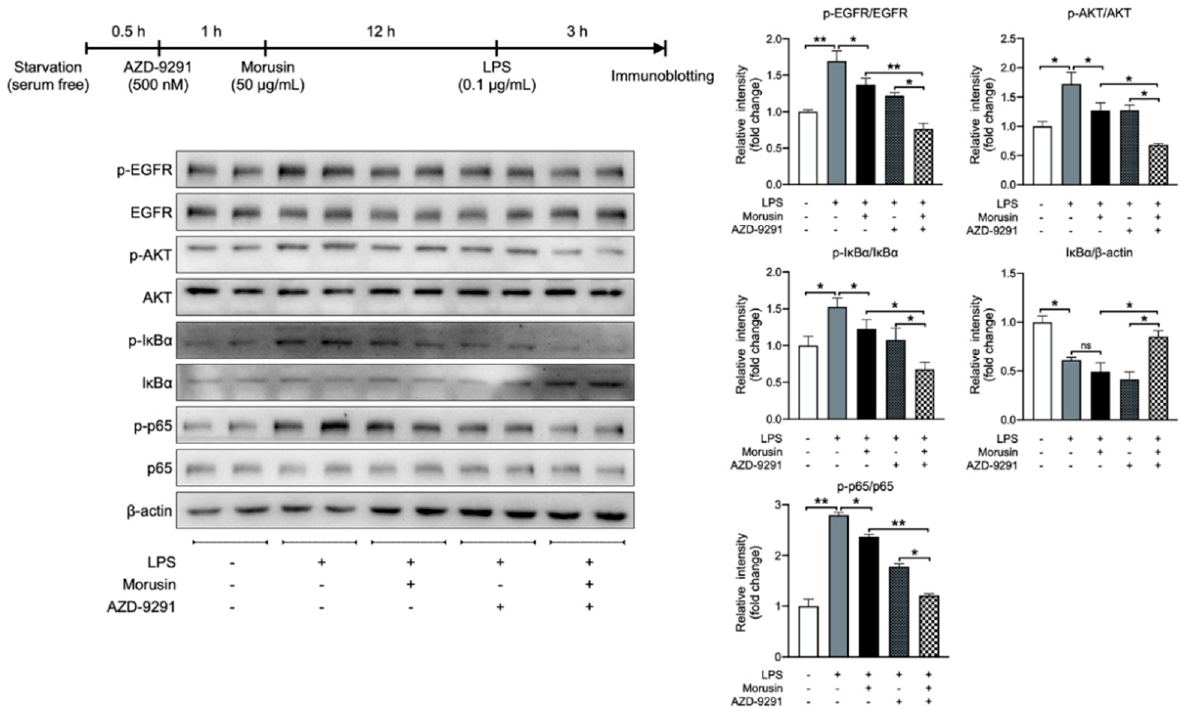
Figure 7. Protein expression level of p-EGFR/EGFR, p-AKT/AKT, p-I κ B α /I κ B α , I κ B α / β -actin, and p-p65/p65 in ruminal epithelial cells (RECs) among different treatments. β -actin was used as reference protein. AZD-9291 is the EGFR inhibitor. RECs were pretreated with AZD-9291 at the concentration of 500 nM or vehicle (1% DMSO) for 1 h, followed by treating without or with 0.1 µg/mL lipopoly- saccharide for 3 h after pretreating with 50 µg/mL of Morusin for 12 h or not ( n = 4, respectively). Data represent mean ± SEM. * p < 0.05, ** p < 0.01. ns, not significant.